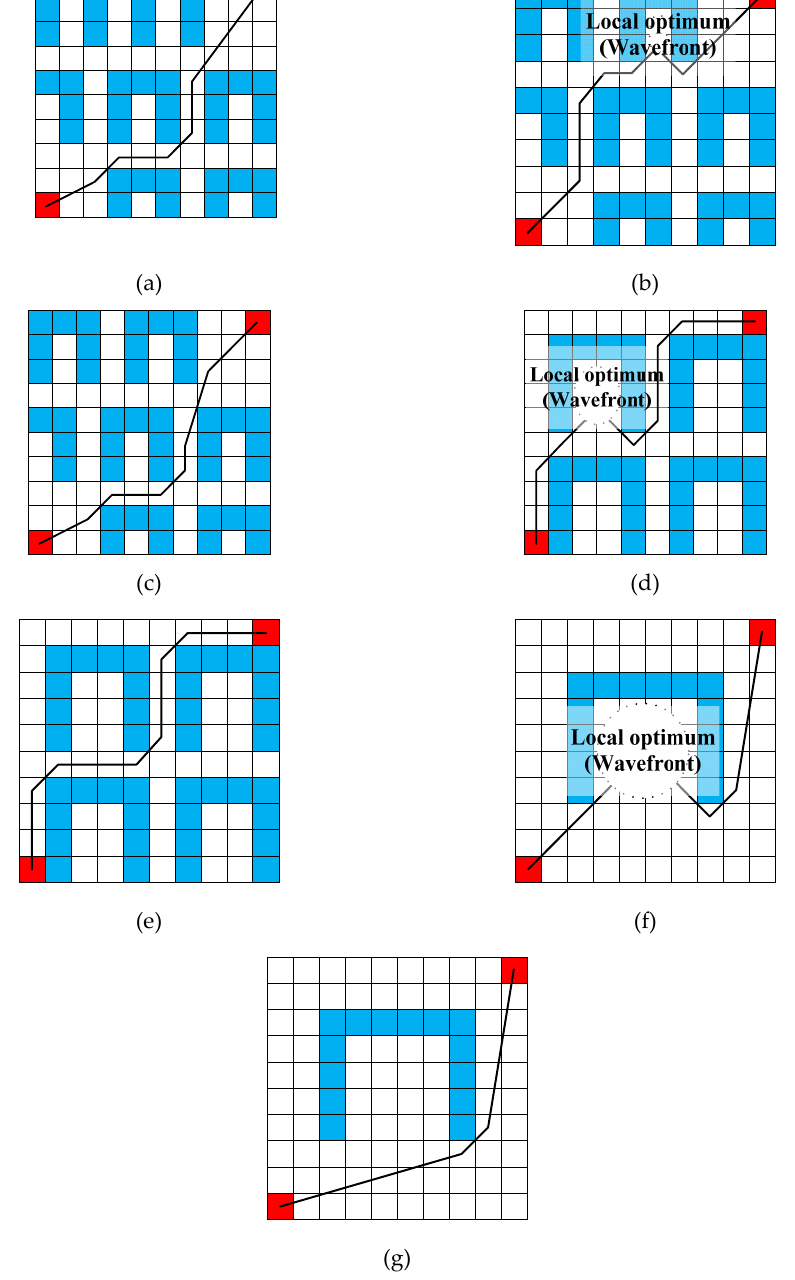
Figure 12. The best path of each algorithms with ‘n’ shape obstacles ( a ) 10_7n (GA, SA, PSO); ( b ) 10_7n (Wavefront); ( c ) 10_7n (Others); ( d ) 10_4n (Wavefront); ( e ) 10_4n (Others); ( f ) 10_1n (Wavefront); and, ( g ) 10_1n (Others) .